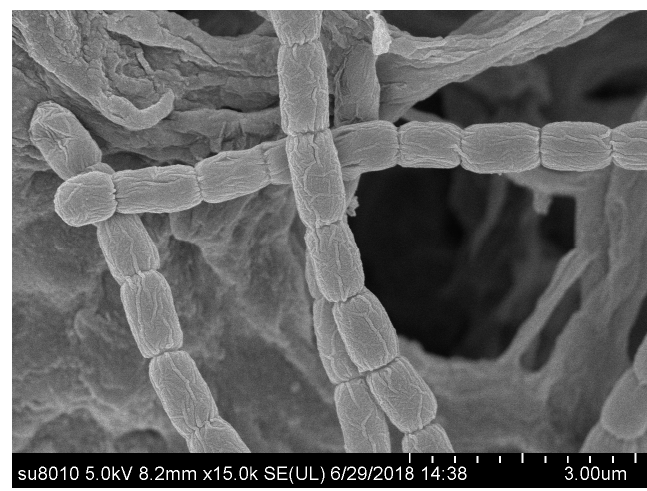
Figure 6. Scanning electron micrograph of strain HAAG3-15 grown on International Streptomyces Project (ISP) 3 medium for three weeks at 28 ◦ C.